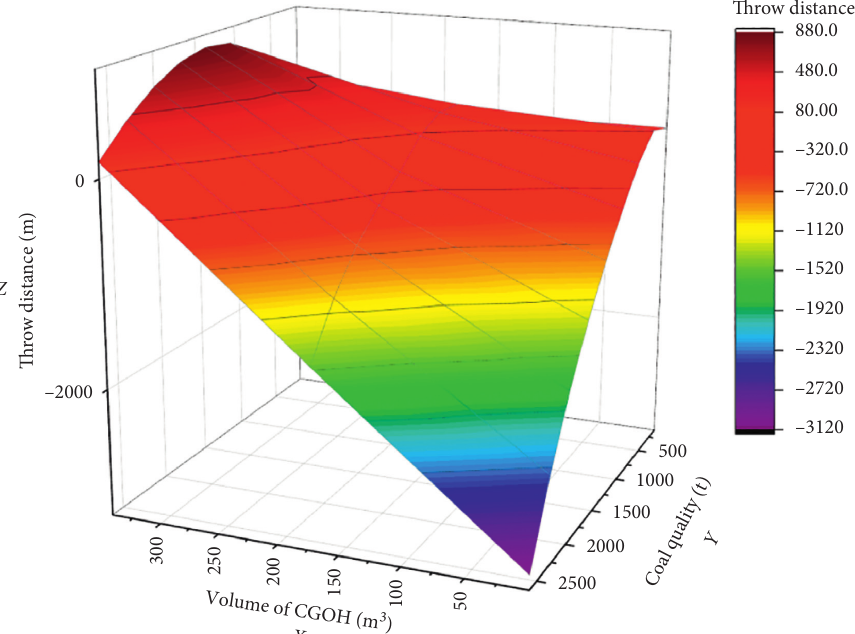
Figure 17: 3D colormap surface of CGOH parameters.